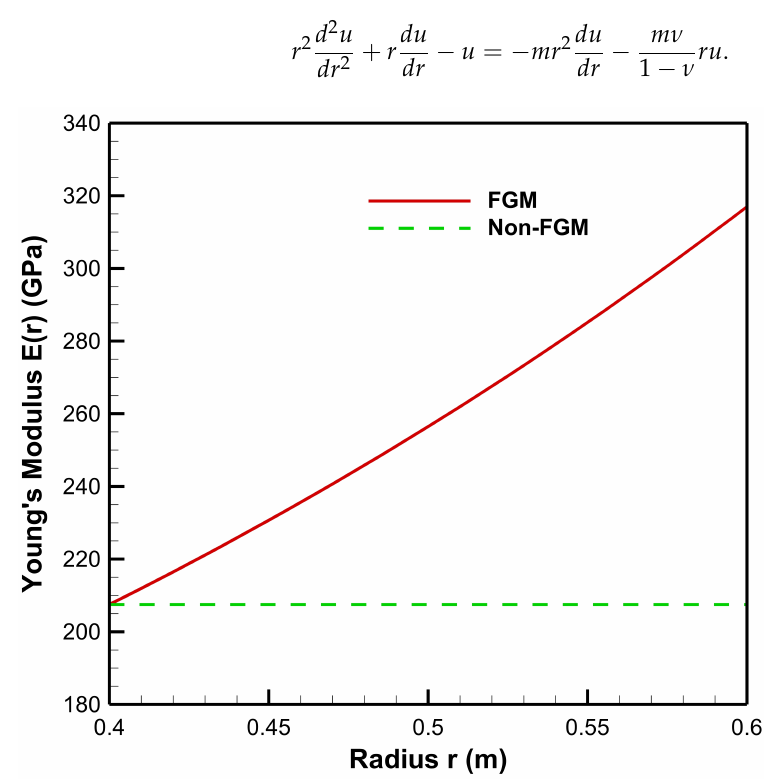
Figure 2. Variation of Young’s modulus along the radius of the